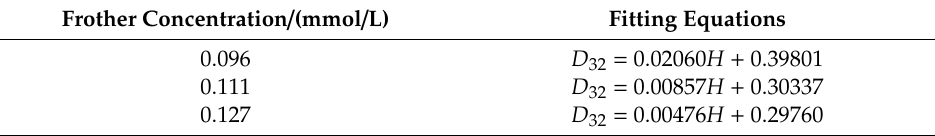
Table 6. Fitting function of bubble Sauter mean diameter and sampling location.